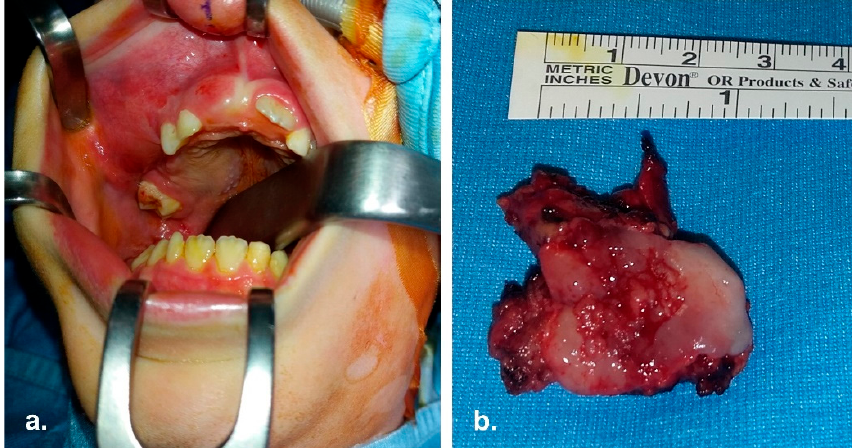
Figure 2. Intra operative pictures. ( a ) Surgical field; the mass involving right maxilla is evident. ( b ) En-bloc enucleation of the